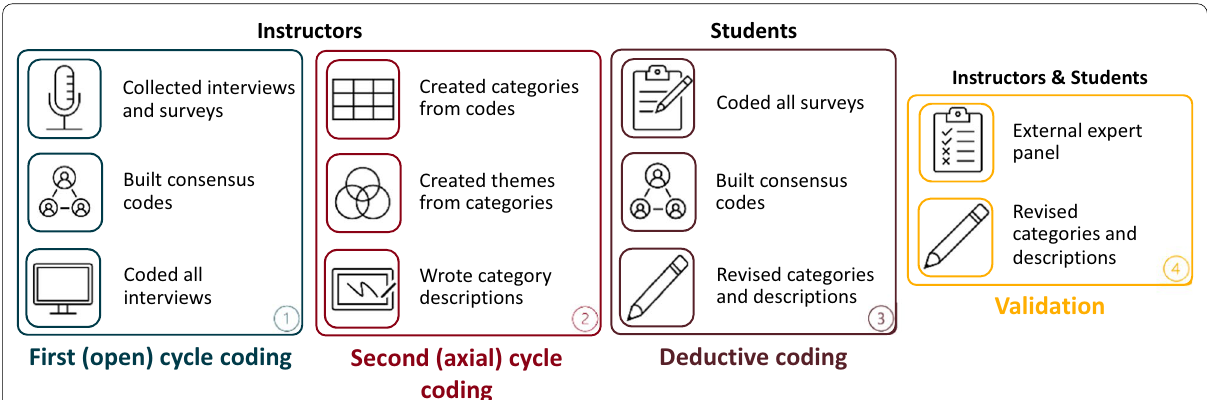
Fig. 3 Qualitative coding and validation approach. We completed first cycle coding for instructor interviews followed by second cycle coding where we generated categories and themes from initial codes. Following instructor data analysis, we coded student survey data using categories generated previously by the instructor data. Following instructor and student analysis, an external expert panel was used to validate categories and descriptions. Blue represents first or open cycle coding, red represents second cycle coding, dark red represents deductive coding with student data, and yellow represents study validation